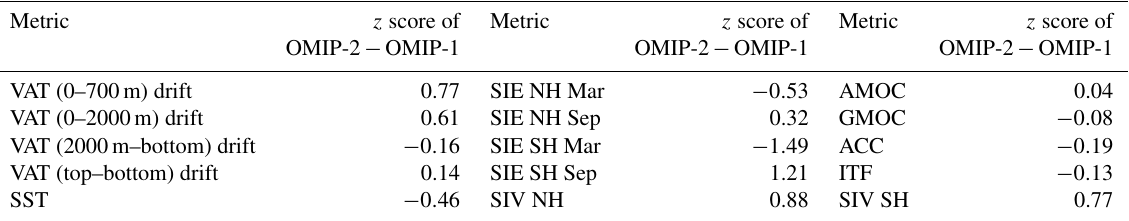
Table 2. The z scores of the difference between OMIP-2 and OMIP-1 simulations for metrics consisting of time series of index values. The differences are evaluated for 1980–2009 of the last cycle. Note that if a z score is beyond ± 1 . 64, the difference is statistically significant at 90% confidence level. The uncertainty of multi-model mean difference is computed based on the method proposed by Wakamatsu et al. (2017). Abbreviations used for metrics stand for VAT (vertically averaged temperature), SST (sea surface temperature), SIE (sea-ice extent), SIV (sea-ice volume), NH (Northern Hemisphere), SH (Southern Hemisphere), AMOC (Atlantic meridional overturning circulation maximum at 26.5 ◦ N), GMOC (global meridional overturning circulation minimum in 2000m–bottom depth at 30 ◦ S), ACC (Antarctic Circumpolar Current passing through the Drake Passage), and ITF (Indonesian Throughflow). Note that VAT drift is evaluated as the deviation of the 1980–2009 mean of the last cycle relative to the annual mean of the initial year of the simulation by each model. Metric z score of Metric z score of